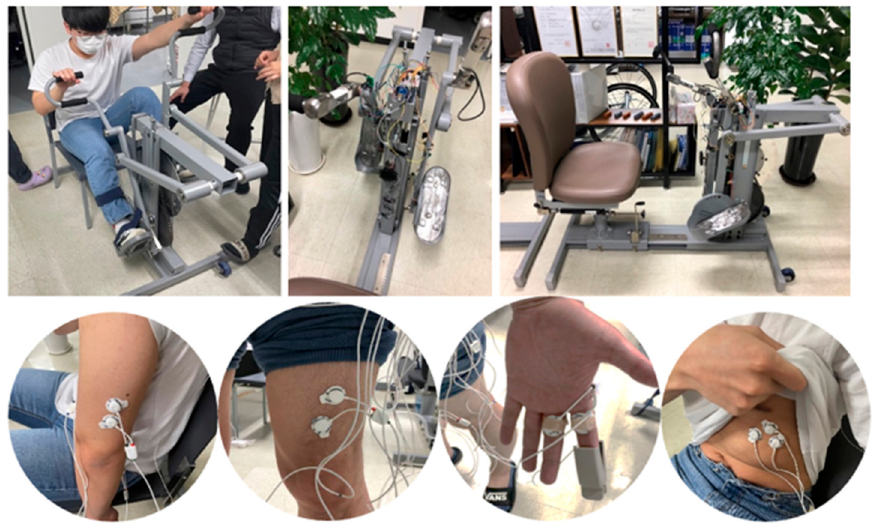
Figure 5. The elephant is an ergometer system developed by the collaborating research team overseeing “Equipment and Biotechnology.”.